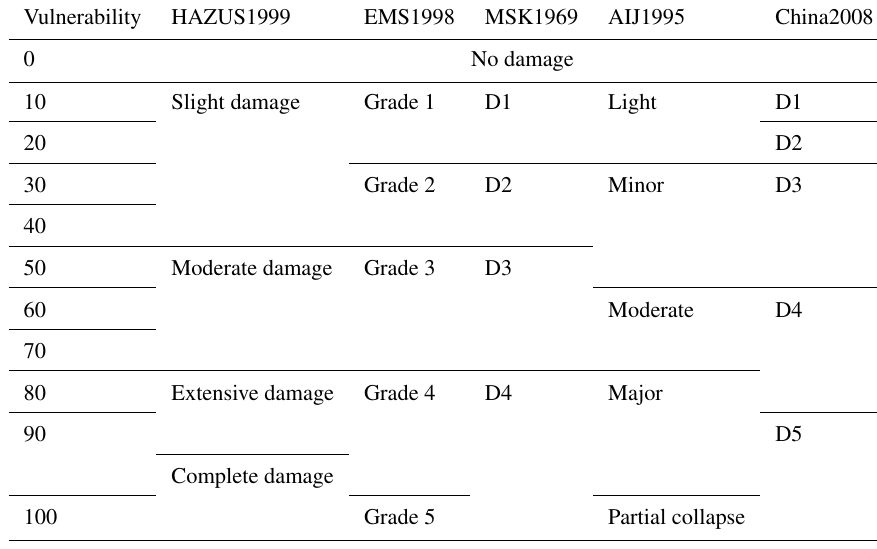
Table 2. Detailed definition of building damage states in GB/T 17742-2008 (2008), China. Damage Structural damage Nonstructural damage Performance-based state description D1 Negligible Cracks only in very few non structural components